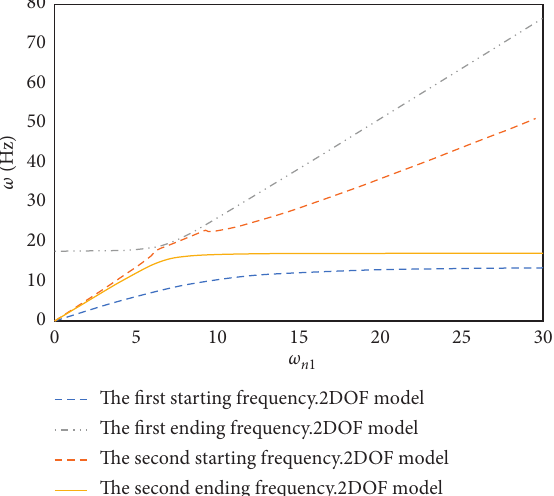
Figure 17: The effect of K parameter on bandgap for the 2DOF model.